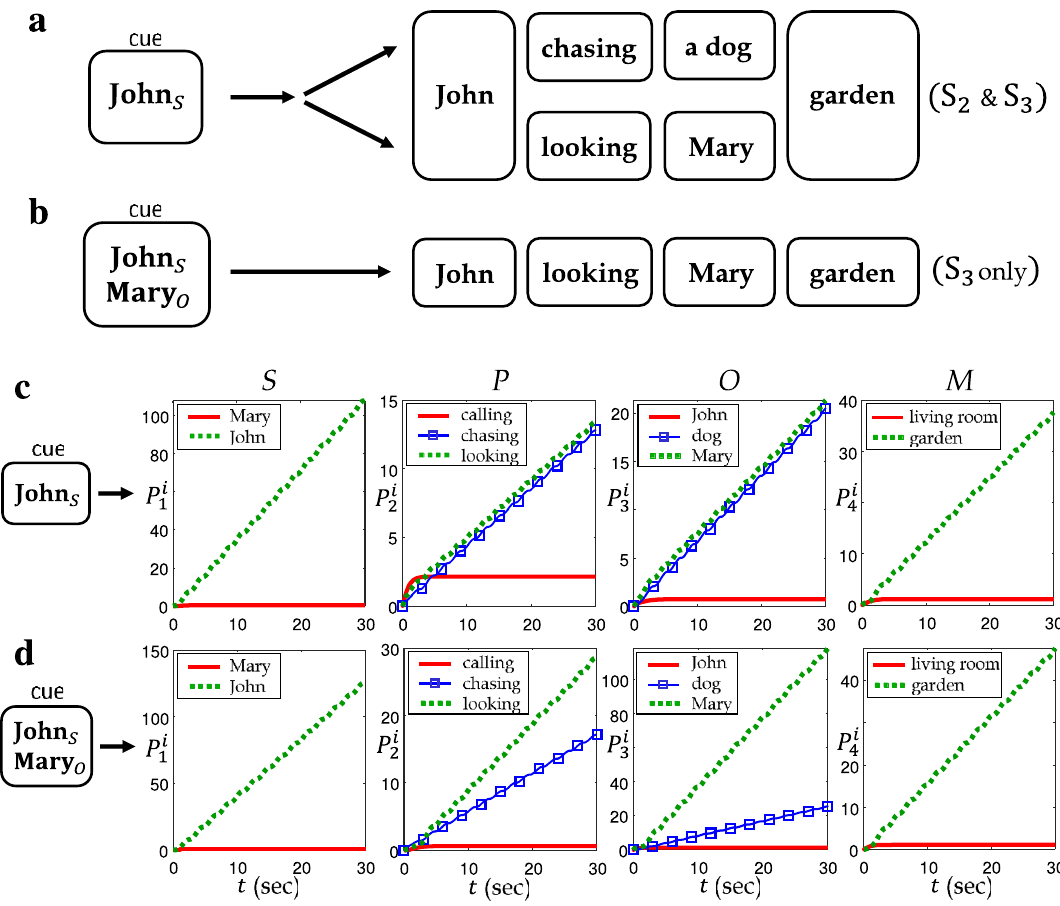
Figure 9. ( a ) Expected result of retrieval by a single component cue John S . ( b ) Expected result of retrieval by multiple component cues John S and Mary O . ( c ) Numerical result of retrieval by a single component cue John S . ( d ) Numerical result of retrieval by multiple component cues John S and Mary O